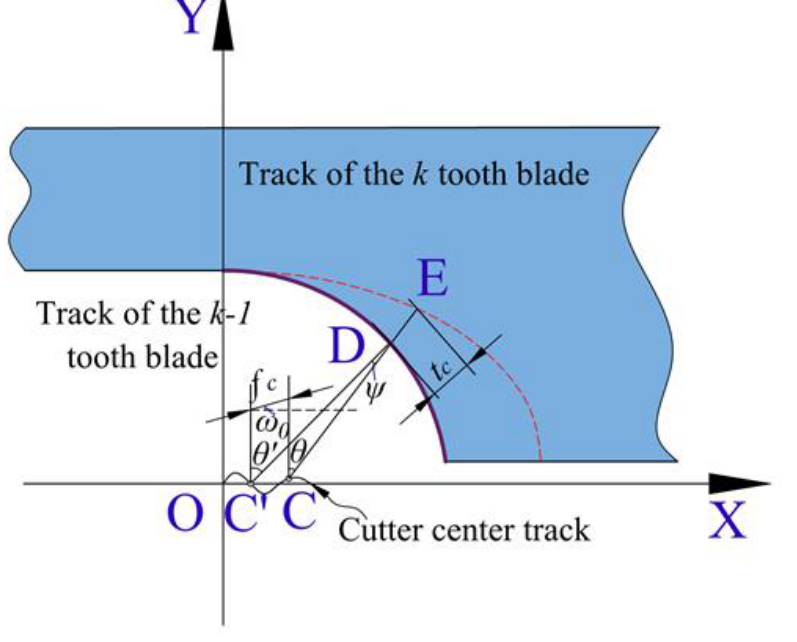
Figure 11. The schematic of the instantaneous cutting thickness.